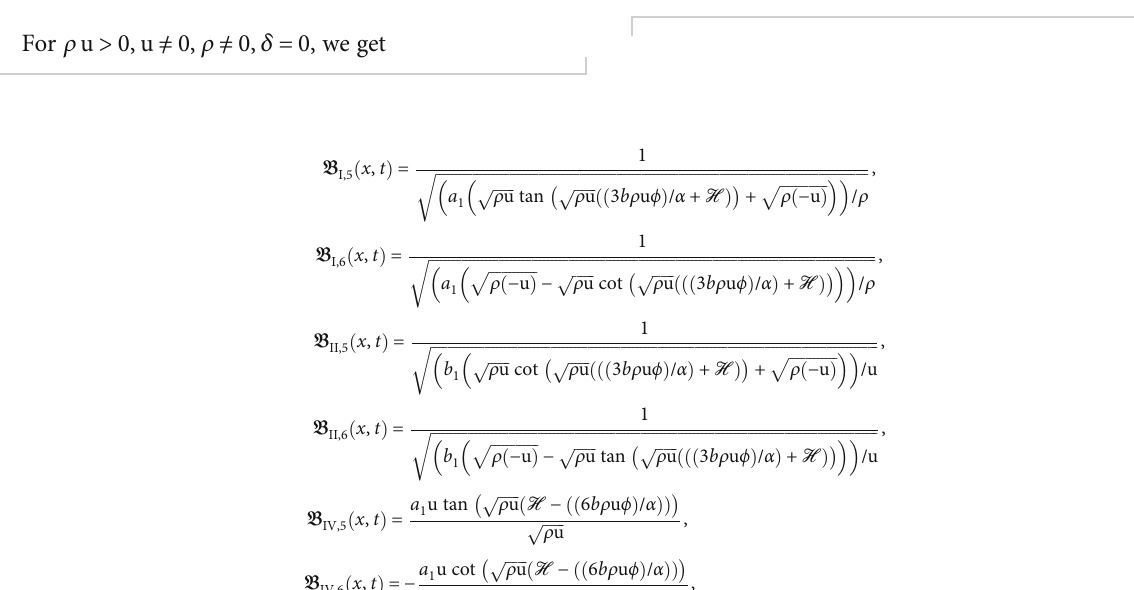
4 ρ p δ 2 − 4 ρ u